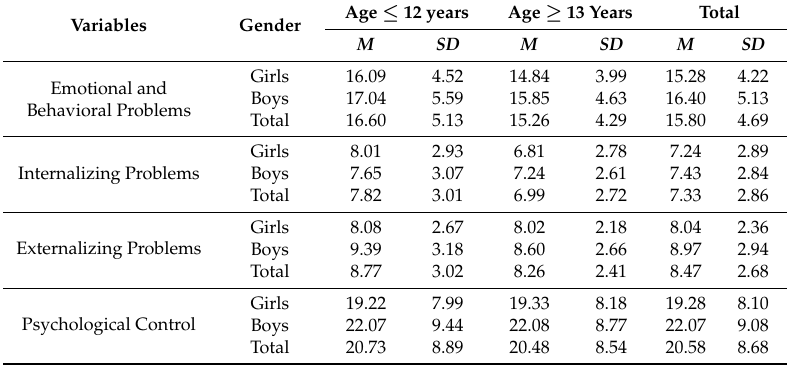
Table 1. Descriptors for the variables of the study: Emotional and behavioral problems, internalizing problems, externalizing problems, and psychological control by age and gender